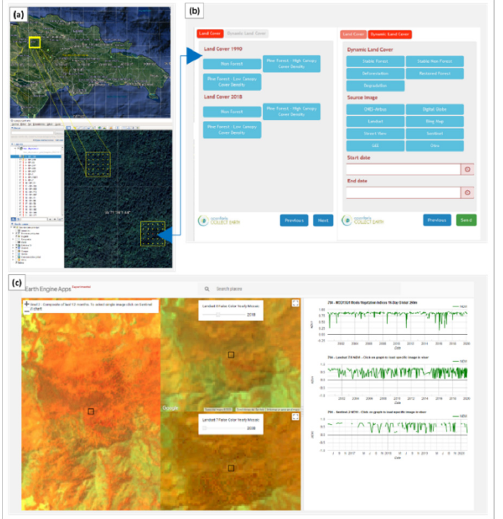
Figure 8. Tools used to collect the reference observations of forest degradation. ( a ) Collect Earth interface in Google Earth Pro; ( b ) Collect Earth survey; ( c ) time series tools online viewer.